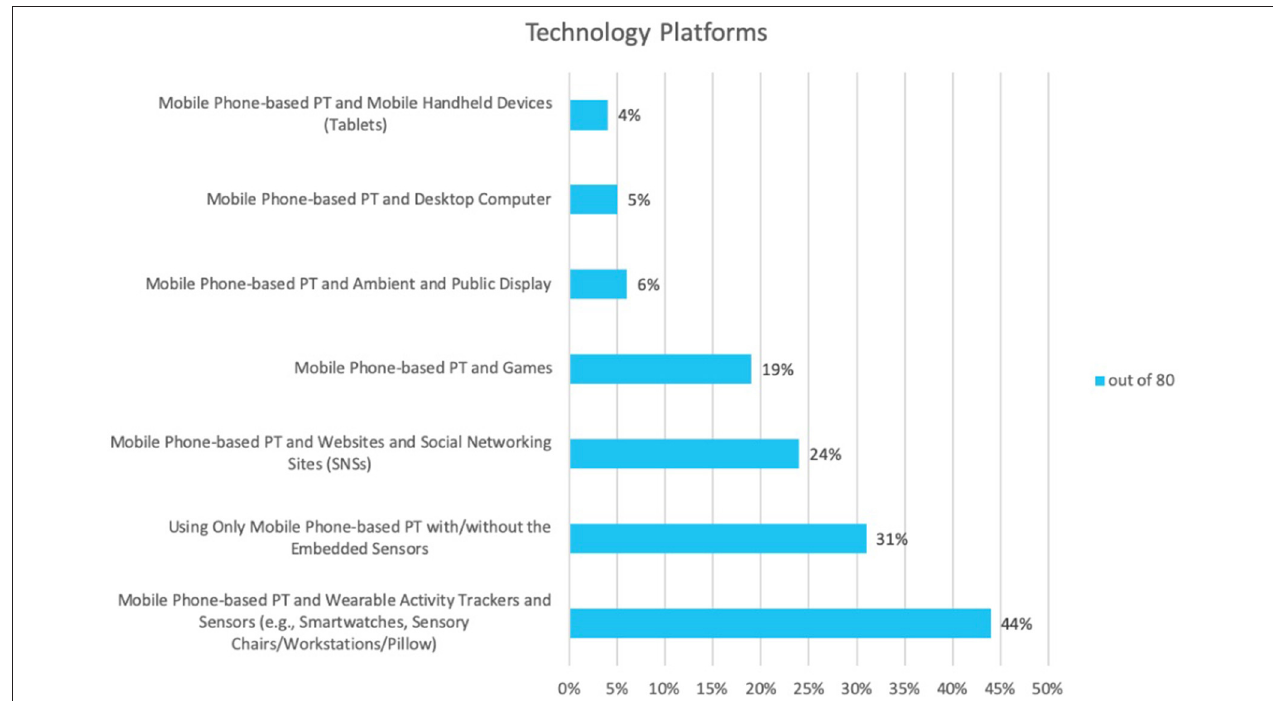
FIGURE 5 | Persuasive technology (PT) platforms used with mobile phone-based PTs.